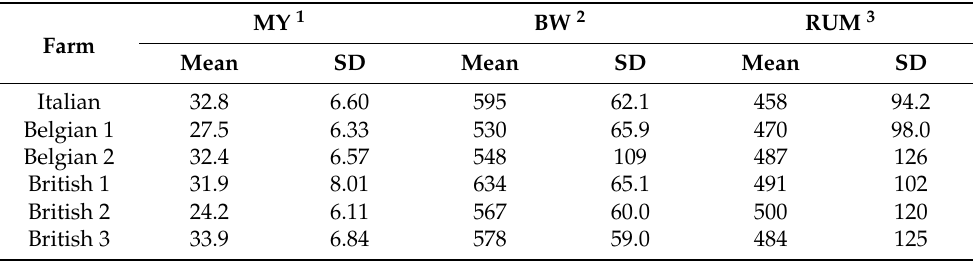
Table 2. Means and standard deviations (SDs) of the recorded sensor